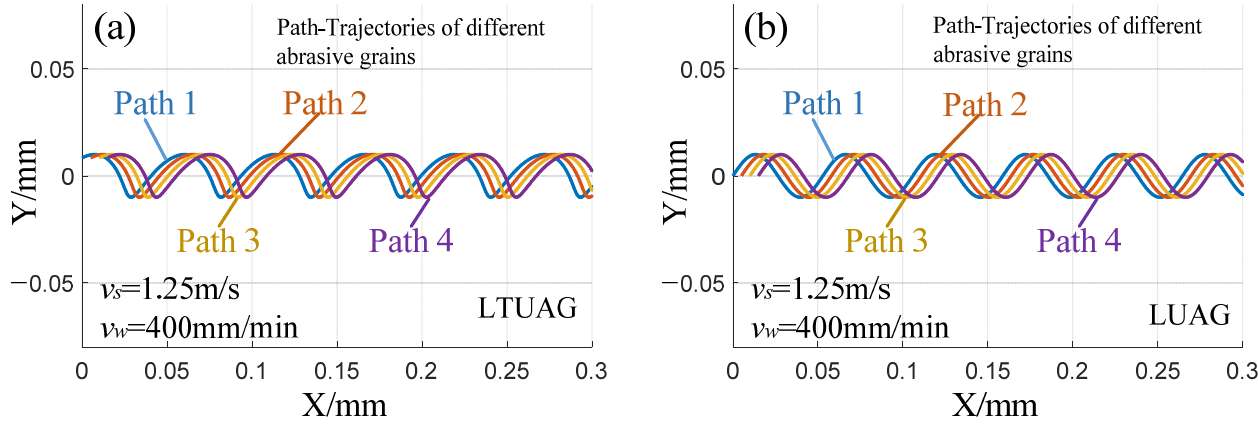
Figure 17. Overlapping trajectories of adjacent abrasive grains. ( a ) Trajectories of LTUAG, ( b ) Trajectories of LUAG.